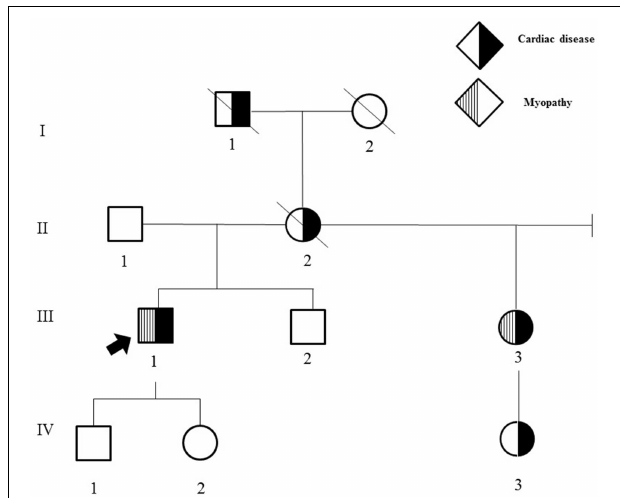
FIGURE 1 | Family history. II-2 had pacemaker placement at 38 years of age and sudden cardiac death at age 62. III-3 had dizziness and syncope onset at age 30, cardiac conduction block requiring pacemaker placement at age 30, extremity weakness and calf muscle wasting onset in the mid-50s; choking episodes beginning in the 50s, and hand numbness and tingling onset in the late 20s that largely resolved following carpal tunnel surgery. In addition, she developed obesity, photophobia, a progressively enlarging palatal cyst protruding to her right nostril resulting in limited sense of smell at age 30, difficulty hearing with background noise in her mid-50s; and irritable bowel syndrome with alternating constipation and diarrhea in her early 50s. III-2 has intellectual disability and autism. I-1 died at age 39 from presumed sudden cardiac death, had a history of “dropsy” with recurrent syncope, edema, and dizzy spells. I-2 died at age 92 years from cancer and required pacemaker placement in her 70s. IV-3 had tachycardia requiring ablation at 10 years of